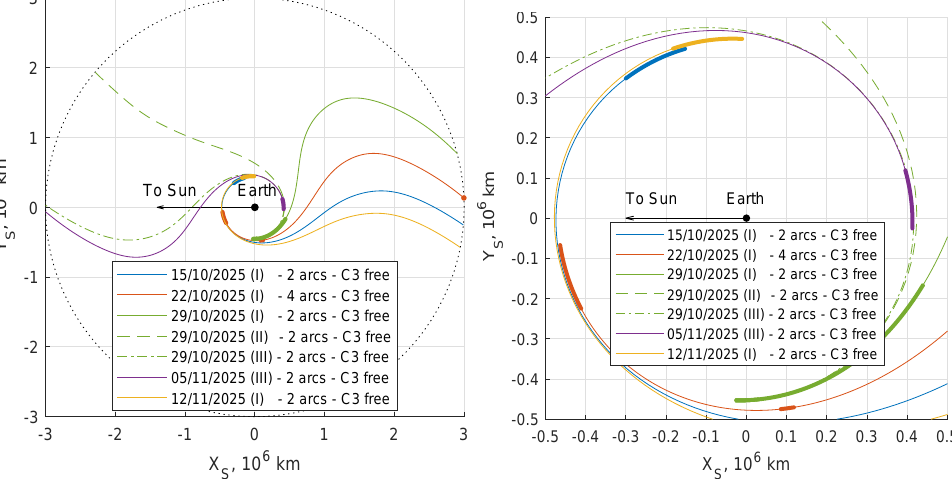
Figure 16. EML2 selected escape trajectories ( left ), departure detailed view ( right ), Sun-Earth syn- odic